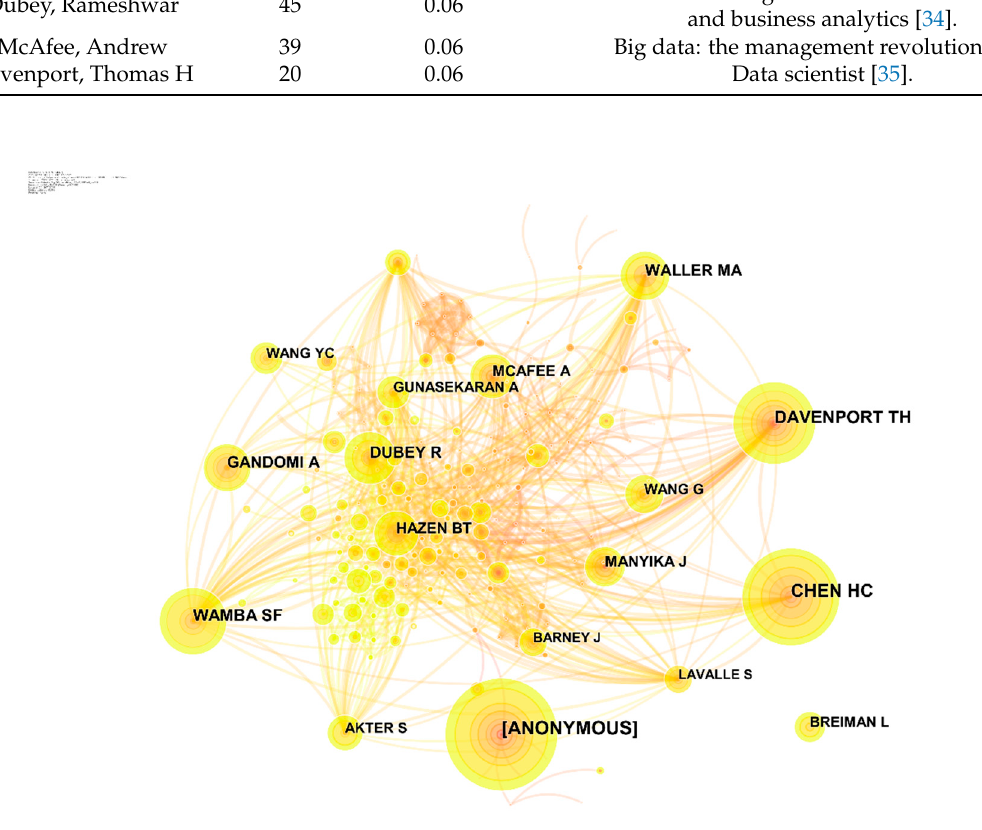
Figure Figure 5. The distribution of cited authors (The links represent collaboration relationship between authors). Table 4. Top 5 authors according to the centrality.